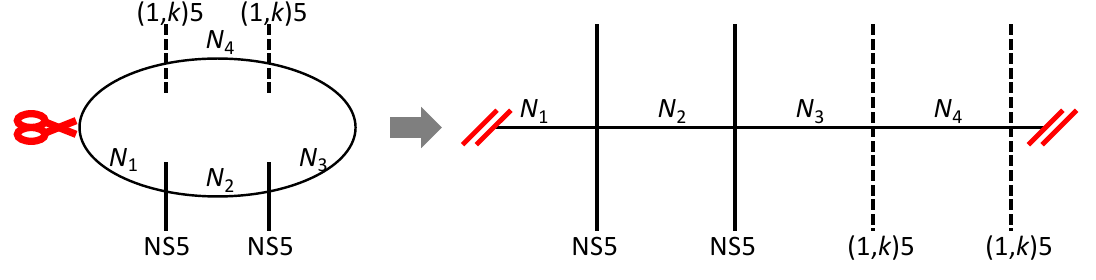
Figure 3 . The brane con(cid:12)guration corresponding to